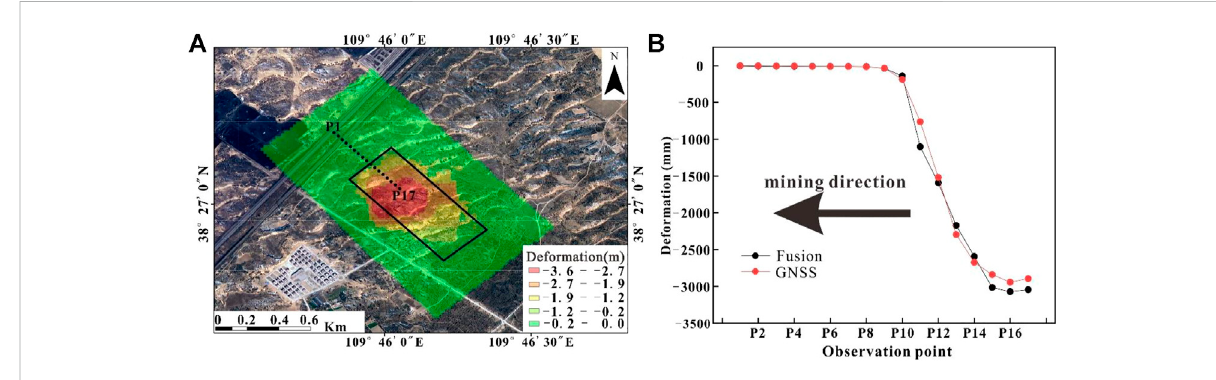
FIGURE 12 (A) Figure fusion of Offset-tracking and interferometric measurement results, (B) Measured observation point GNSS and vertical deformation after the fusion